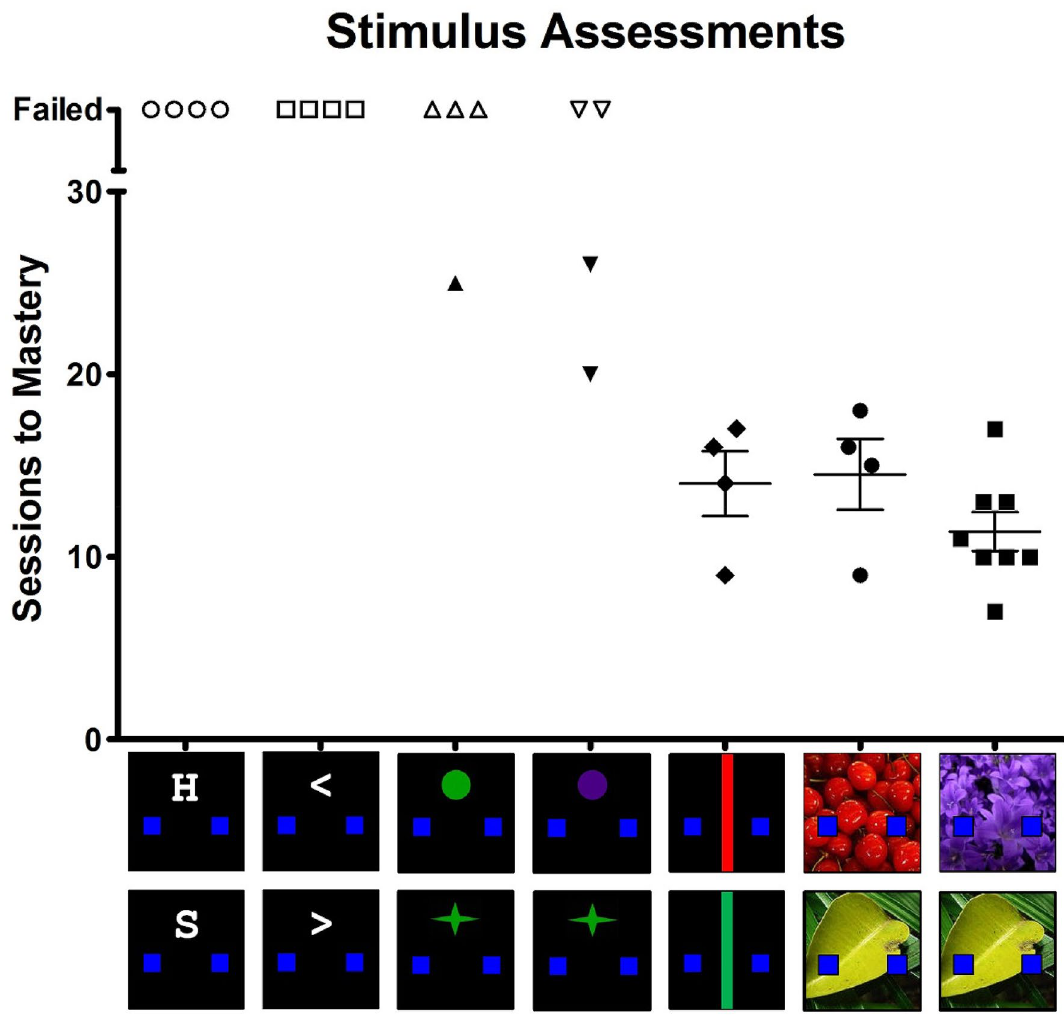
Figure 1. Discrimination training outcomes across touchscreen-based visual stimuli examined. Each data point represents the number of sessions required to meet ≥ 80% correct discrimination mastery criterion (or failure) for an individual subject and, when all subjects mastered the discrimination, horizontal lines represent group mean (± (lux) of each stimulus. To capture chamber-wide illuminance values, the photo detector of a light meter (Model LT45, Extech Instruments, Nashua, NH) was positioned in the center of the chamber and perpendicular to the touchscreen, 15 cm from the screen and 5 cm above the floor bars (i.e., approximate rat eye level). Discrimina- tion between two letters (H and S, n = 4) was evaluated because these letters were used as stimuli in the original flanker study 24 and numerous subsequent experiments in humans 37,49,50 . Left and right arrows (< and >, n = 4) were examined because these stimuli are also frequently used in flanker studies with human participants 51–53 . Assess- ing whether two different green geometric shapes (green circle and green star, n = 4) could be discriminated was examined because one of the 2 types of retinal cone cells in the eye of Long-Evans rats 54 has peak sensitivity at wavelengths approximating 510 nm 55,56 , which appears as a green hue. Assessing the ability of rats to discriminate between 2 different geometric shapes that also differed in color (purple circle and green star, n = 4) was examined because the second type of cone cell in Long-Evans rats displays peak sensitivity at wavelengths approximating 358 nm 57,58 . Although this second wavelength is in the ultraviolet portion of the color spectrum, purple is the closest visible color on the spectrum that can be presented on a standard touchscreen monitor. Vertical stripes (red stripe and green stripe, n = 4) were studied given their ability to span from the bottom to the top of the touchscreen and allow for flanking on the left and right. Finally, to evaluate whether complex photographic stimuli might provide additional colors, contrasts, and contours to assist the development of stimulus control, a predominately red and a predominately green photograph (red cherries and a green leaf, n = 4) or a predominately purple and a predominately green photograph (purple flowers and a green leaf, n = 8) were studied. Each stimulus pair described above was studied in a different group of male rats that were otherwise experimentally-naïve. All stimuli are available from the corresponding author upon request.